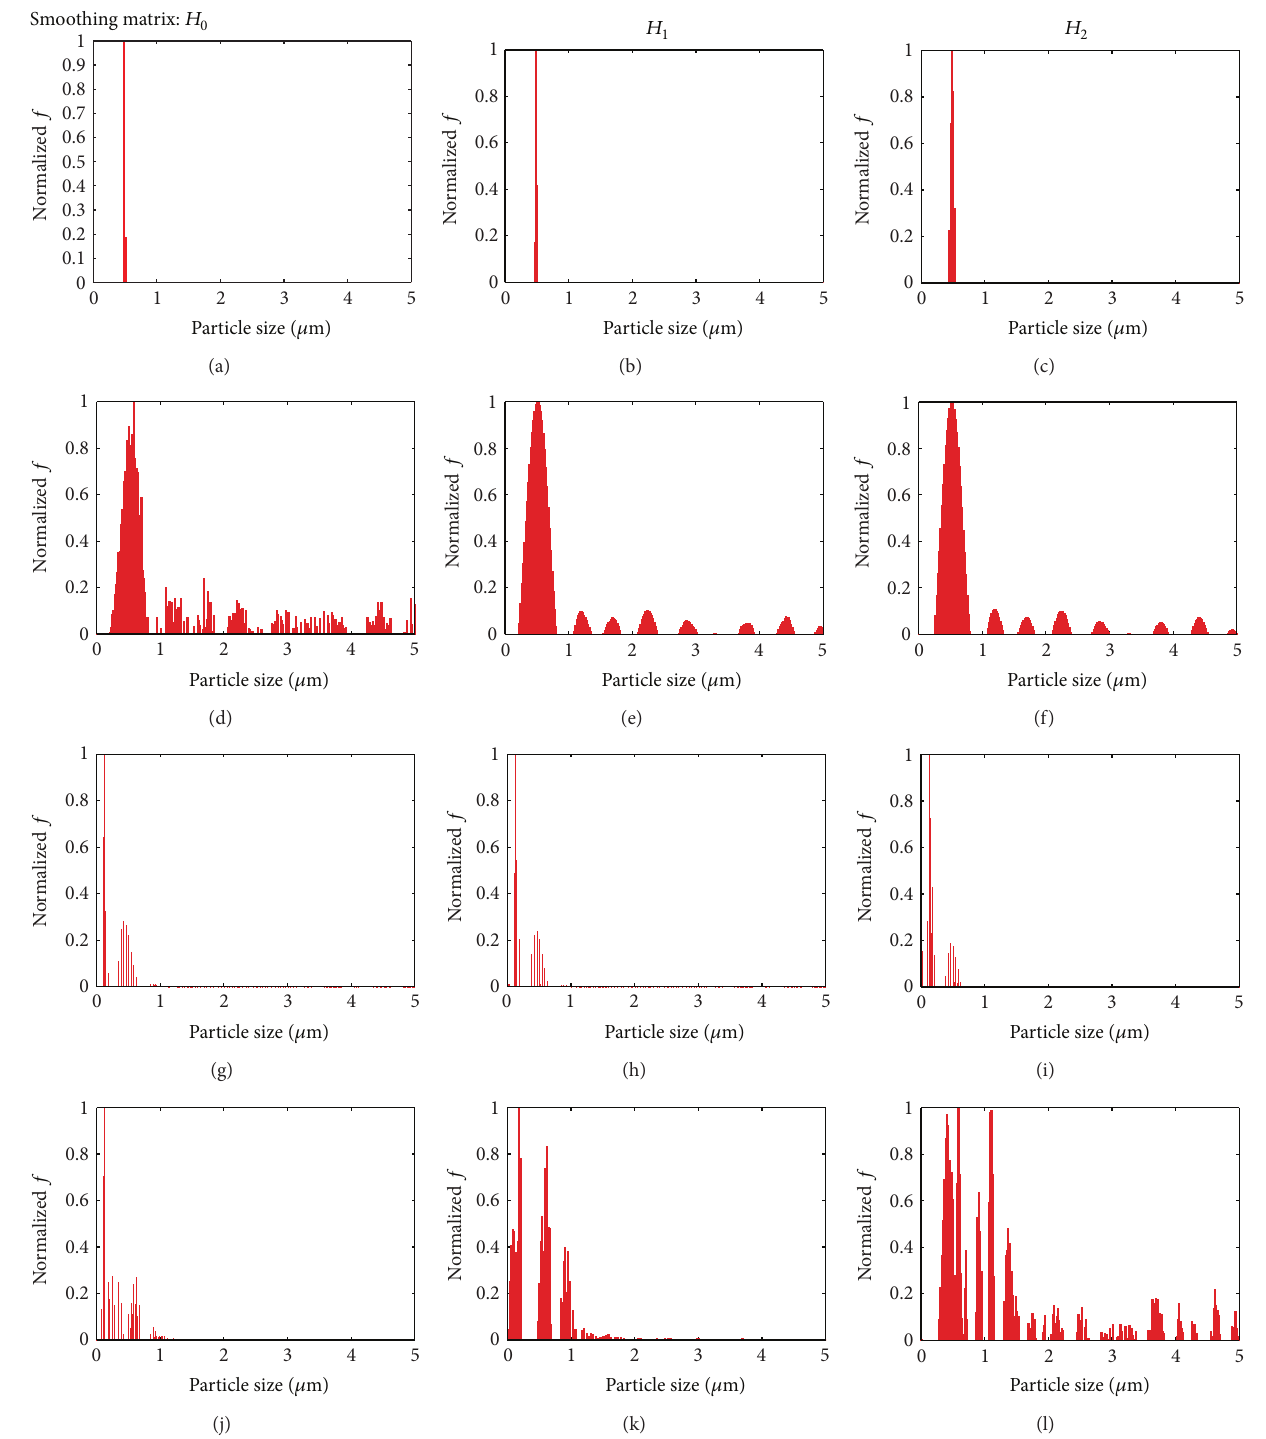
= 0.497 𝜇 m) for the different smoothing nominal